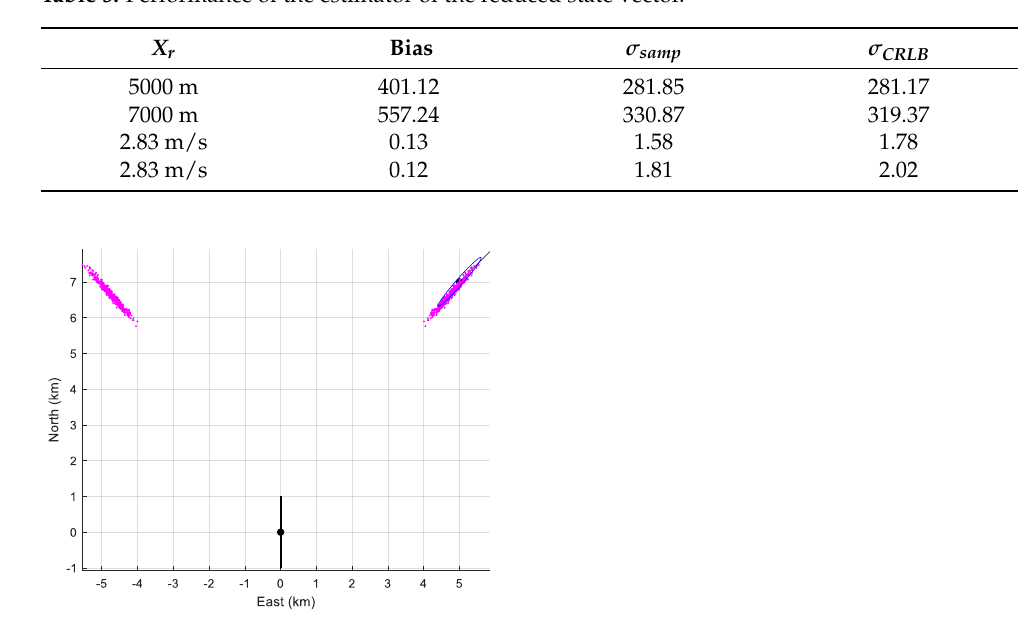
Figure 9. The location of the sensor array (in black), the cloud of the 500 estimates and the 90%−con- fidence ellipse when 𝐷 = 2000 m, 𝑧 𝐴𝑠 = 300 m, and 𝑧 𝑇 = 100 m. The symmetrical cloud is plotted confidence ellipse when D = 2000 m, z As = 300 m, and z T = 100 m. The symmetrical cloud is too. plotted